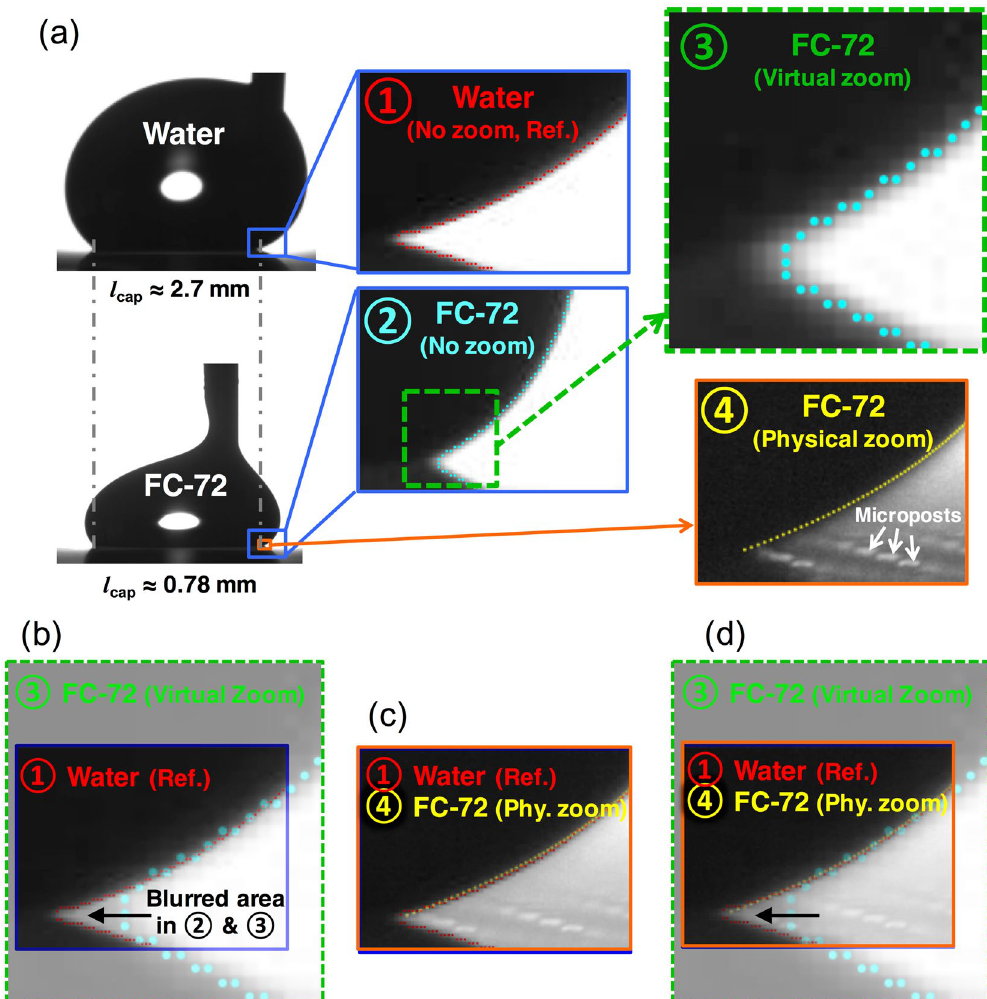
the advancing menisci of water and FC-72 close to the contact point at no zoom. ③ and ④ demonstrate the advancing meniscus of FC-72 under virtual and physical zoom set to be inversely proportional to the ratio of its capillary length to water. ( b ) Overlap of ① and ③ shows the matching of water and FC-72 (virtual zoom) advancing menisci except the blurred region in FC-72 due to limited resolution and lighting. ( c ) Overlap of ① and ④ shows the matching of water and FC-72 (physical zoom) advancing menisci with the blurred region resolved by higher magnification. ( d ) Overlap of ① , ③ and ④ summarizes the conclusions from ( b ) and ( c